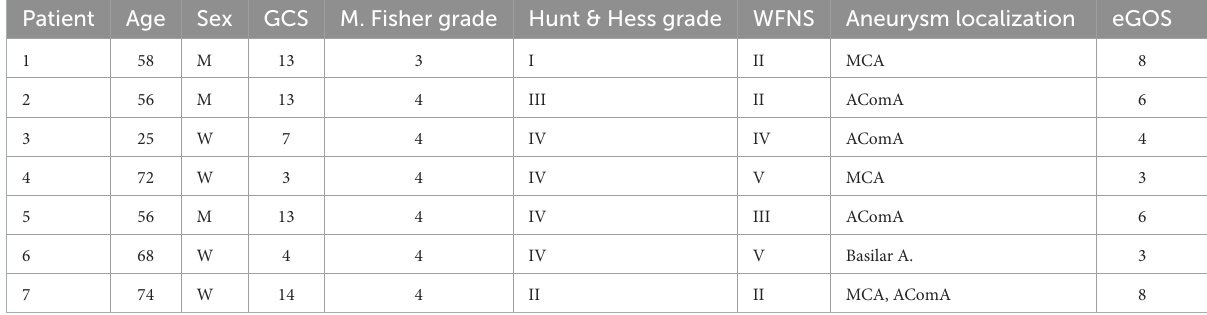
TABLE 1 Patient characteristics.